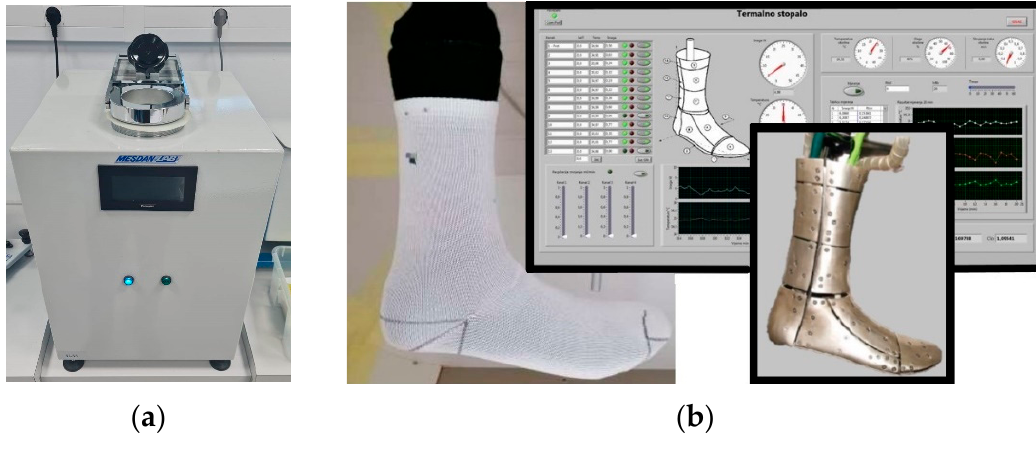
Figure 7. Evaluation of the comfort-related properties of socks: ( a ) the device for determining the air permeability of the sock knits, Air Tronic Mesdan S.p.A.; ( b ) the thermal foot manikin system.